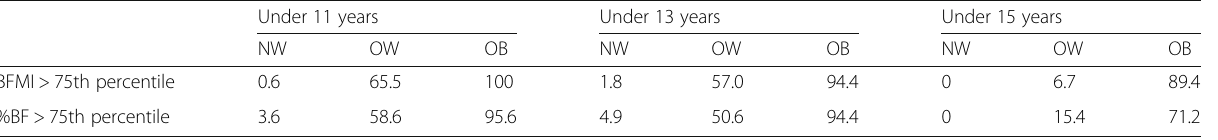
Table 2 Percentage of normal-weight, overweight, and obese young male rugby players (IOTF criteria) having an excess body fat classified by BFMI and %BF above the 75th